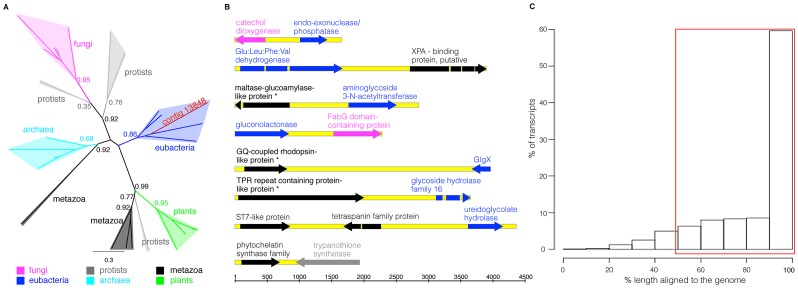
Foreign genes in the A. ricciae genome.(A) Phylogenetic tree for one exemplar bdelloid transcript (contig 13848) encoding an acetyl-CoA synthetase. Branch colours represent different taxa: metazoa, black; eubacteria, blue; archaea, light blue; fungi, pink; protists, grey; plants, green. Numbers on nodes represent aLRT support. (B) Physical linkage of foreign genes to neighbouring genes in the genome: eight different Sanger sequenced and assembled genomic regions, with arrows showing gene length and orientation (metazoa, black; eubacteria, blue; fungi, pink; protists, grey); introns are indicated as interruptions. Bdelloid genes previously identified in A. vaga are marked with an asterisk. In both the first and fourth genomic regions shown, the two foreign genes belong to different taxa (fungi and bacteria). Scale, bp. See also Figure S2 and Table S1. (C) Genomic coverage of A. ricciae foreign transcripts. Histogram of the percentage length aligned to the draft genome for all foreign transcripts. The red box indicates all foreign transcripts which align to the draft genome along greater than 50% of their length.